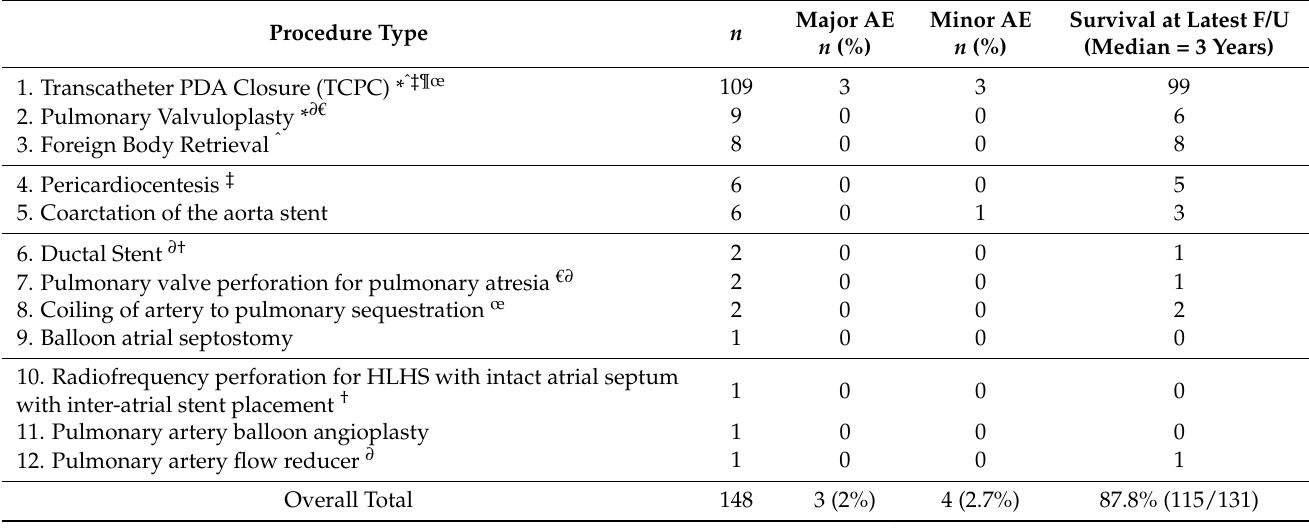
Table 3. Adverse Events (AE) and Follow-Up